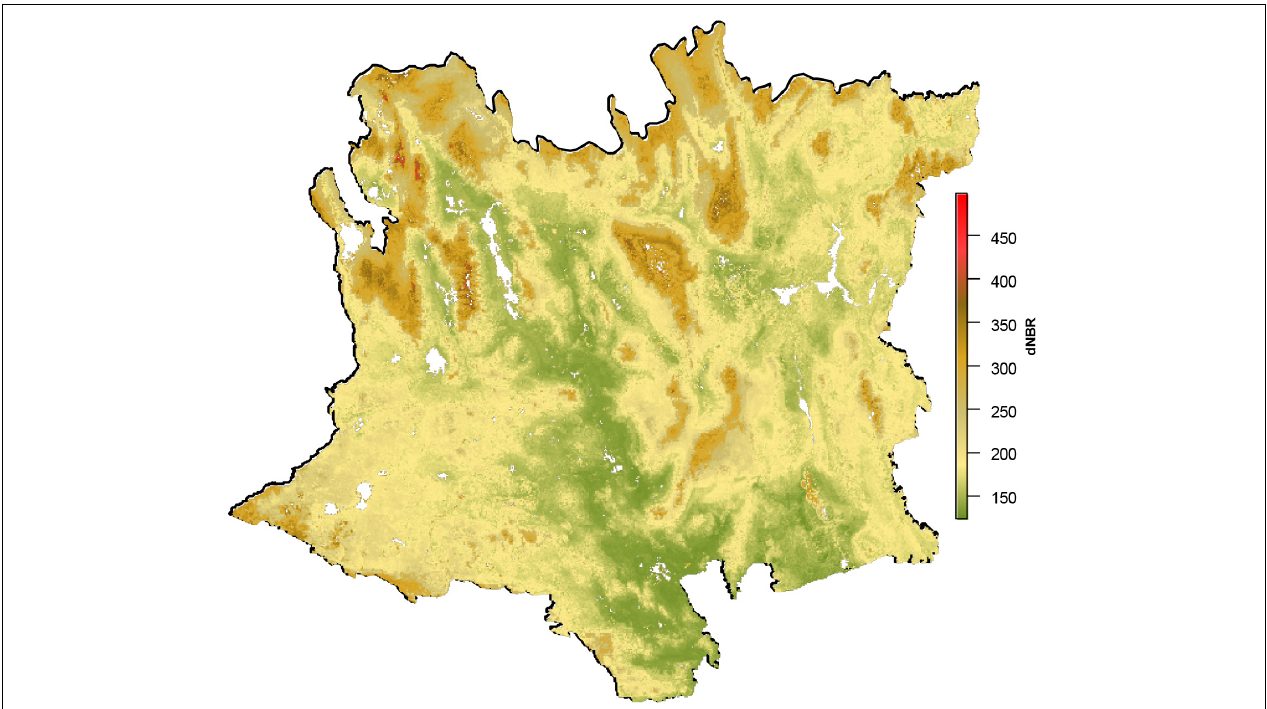
FIGURE 9 | Predicted values for an index of burn severity (difference normalized burn ratio; dNBR) in the Mojave Desert of North America. Predictions were derived from a Random Forest model with 9 variables representing variability in topography, climate, and